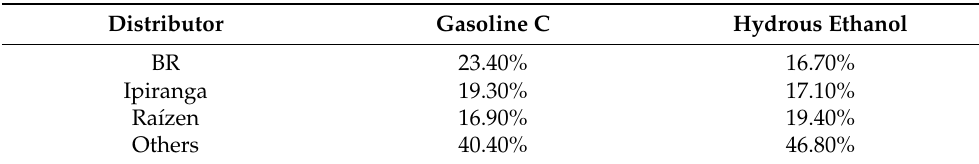
Table 1. Market share of the main distributors, by type of fuel, in 2019. Source: own elaboration with data from